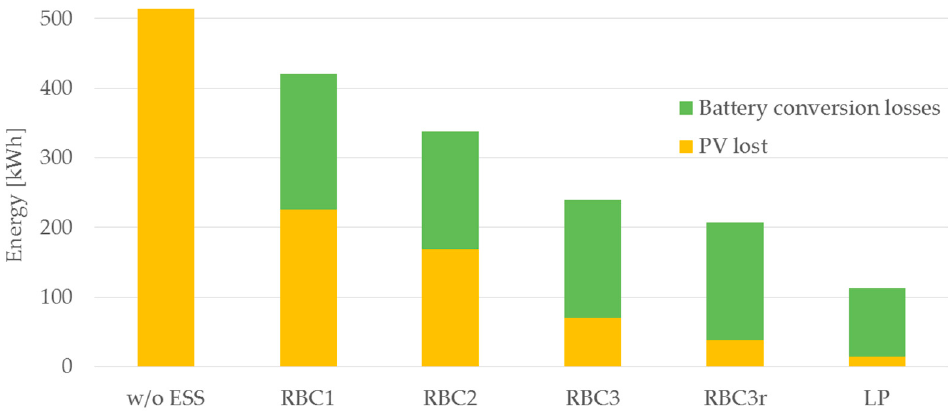
Figure 18. PV lost and battery losses.